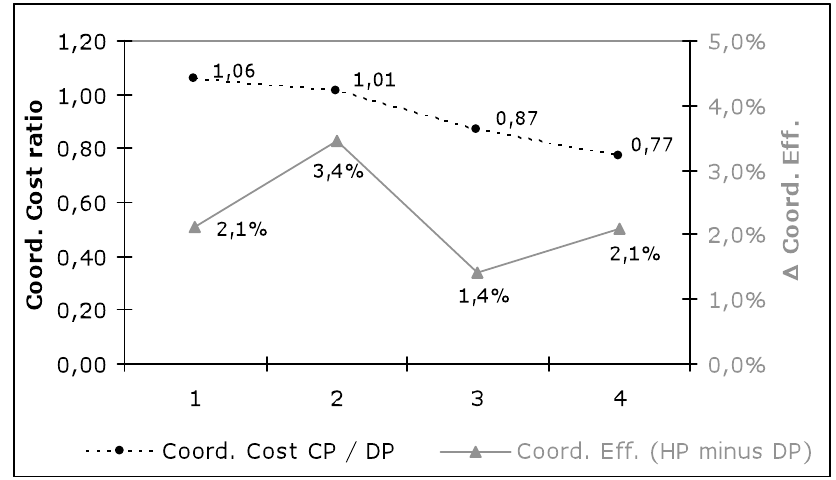
Figure 6. “Coordination cost and coordination efficiency of different coordination